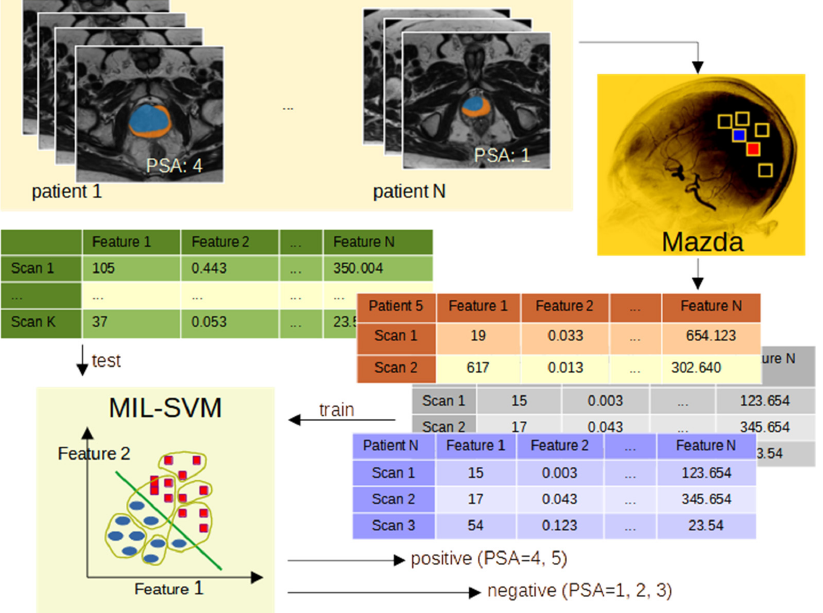
Figure 3. The overview of the presented approach.